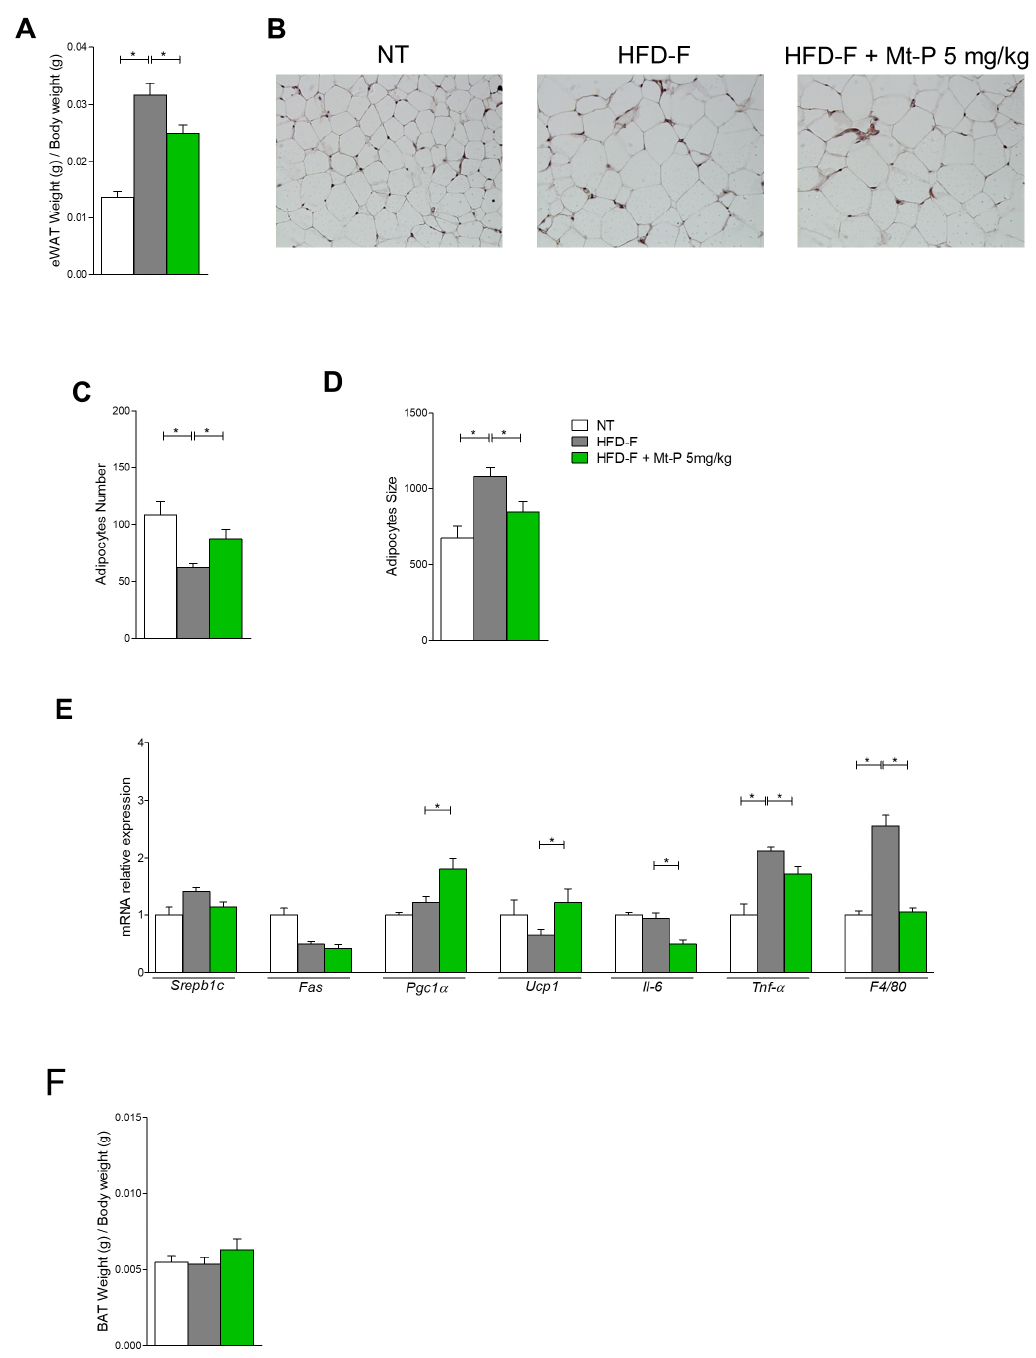
Figure 10. E ff ects of AhR activation in extrahepatic tissues. C57BL / 6 male mice were fed a high fat diet (HFD) and fructose or normal chow diet as described before (see Section 2). ( A – C ) : Results in epididymal white adipose tissue (eWAT). ( A ) Ratio eWAT weight / body weight. ( B ) Hematoxylin and eosin (H&E) staining of white adipose tissue sections obtained at the end of the study. The images shown are representative of at least 10 others, each one obtained from an individual mouse, showing a similar pattern of regulation (magnification 4 × ). ( C ) Adipocytes number and ( D ) size obtained from analysis of H&E staining performed with ImageJ. ( E ) Changes in mRNA expression of eWAT genes. ( F ) Ratio brown adipose tissue (BAT) weight / body weight. Values are normalized relative to Gapdh mRNA and are expressed as mean ± SEM of six / ten mice per group (NT = 6; HFD-F = 8; HFD-F + Mt-P 5 mg / kg = 10) (* p <